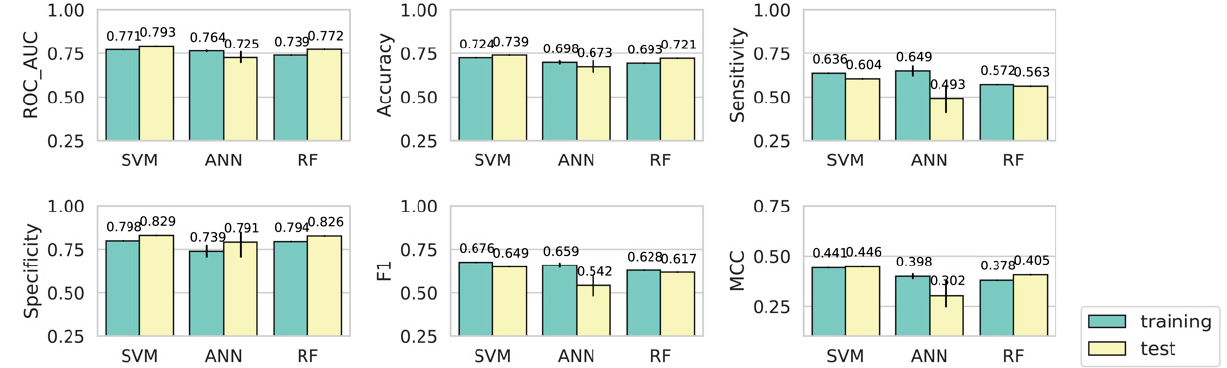
Figure 4. Validation of model performance using an independent test dataset. The SVM, ANN, and RF models were constructed using the full set of developmental brain gene expression features. Model performance metrics in cross-validations (training) and on the independent test dataset (test) with error bars are shown.